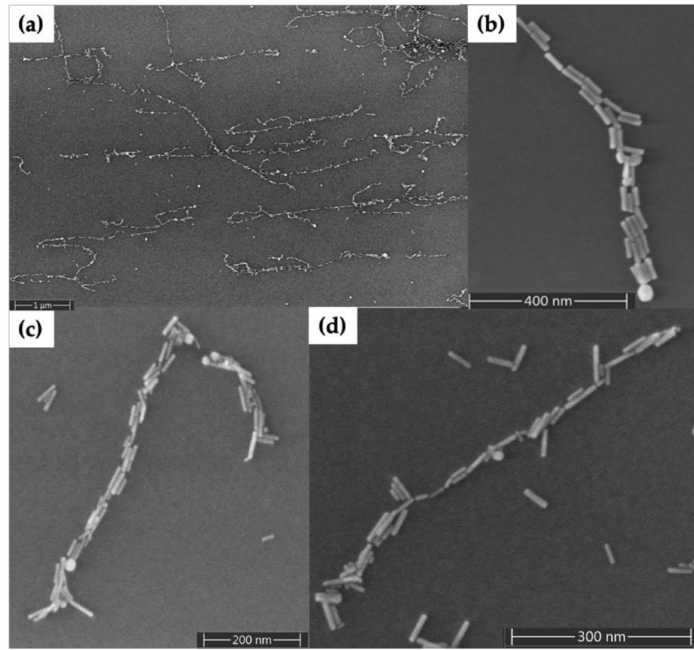
Figure 3. Scanning electron microscopy (SEM) images of Au nanorod-seeded DNA nanotubes. ( a ) Large area view. ( b – d ) Zoom views of individual DNA nanotubes seeded with Au